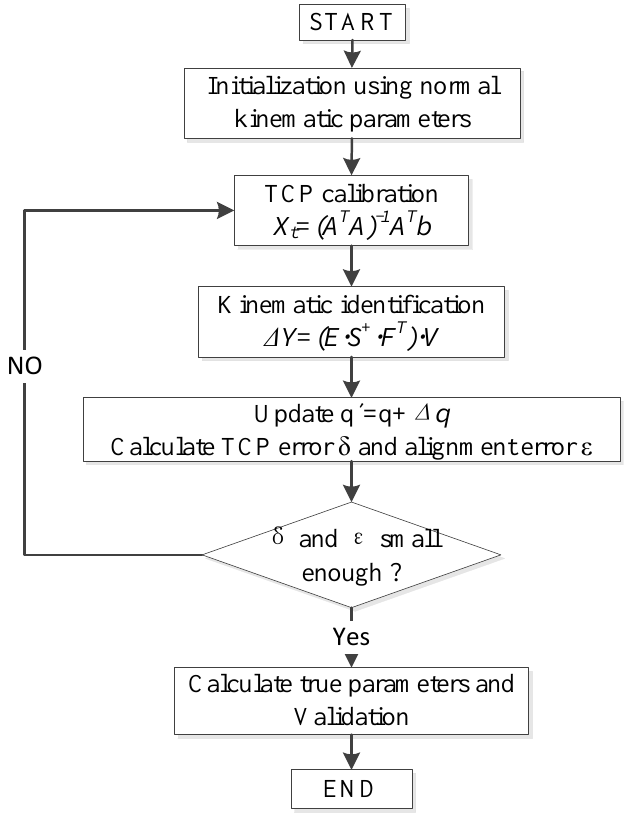
Figure 4. Flow chart of the robot self-calibration